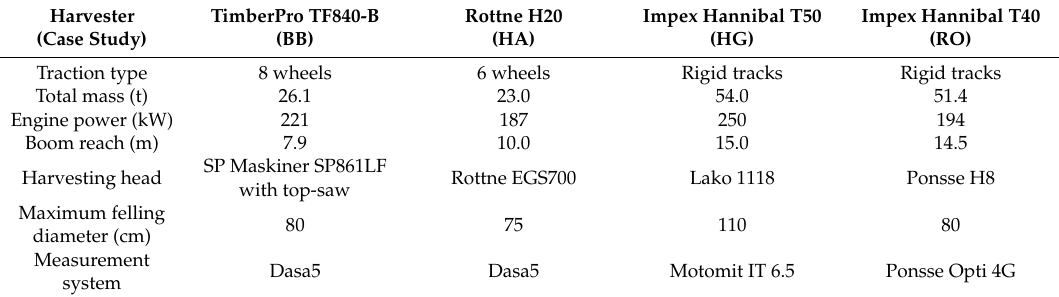
Table 1. Specifications of harvesters and associated harvesting heads used at the four study sites.